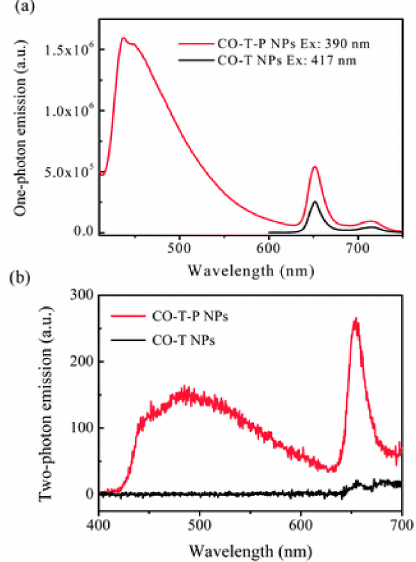
Figure 5. ( a ) Emission spectra of CPNs with or without PFEMO under excitation at their individual absorption maximum (390 nm for CO-T-P NPs and 417 nm for CO-T NPs); ( b ) comparison of emission spectra of CPNs with or without PFEMO under two-photon excitation at 800 nm. Republished with permission of The Royal Society of Chemistry from [63]; permission conveyed through Copyright Clearance Center